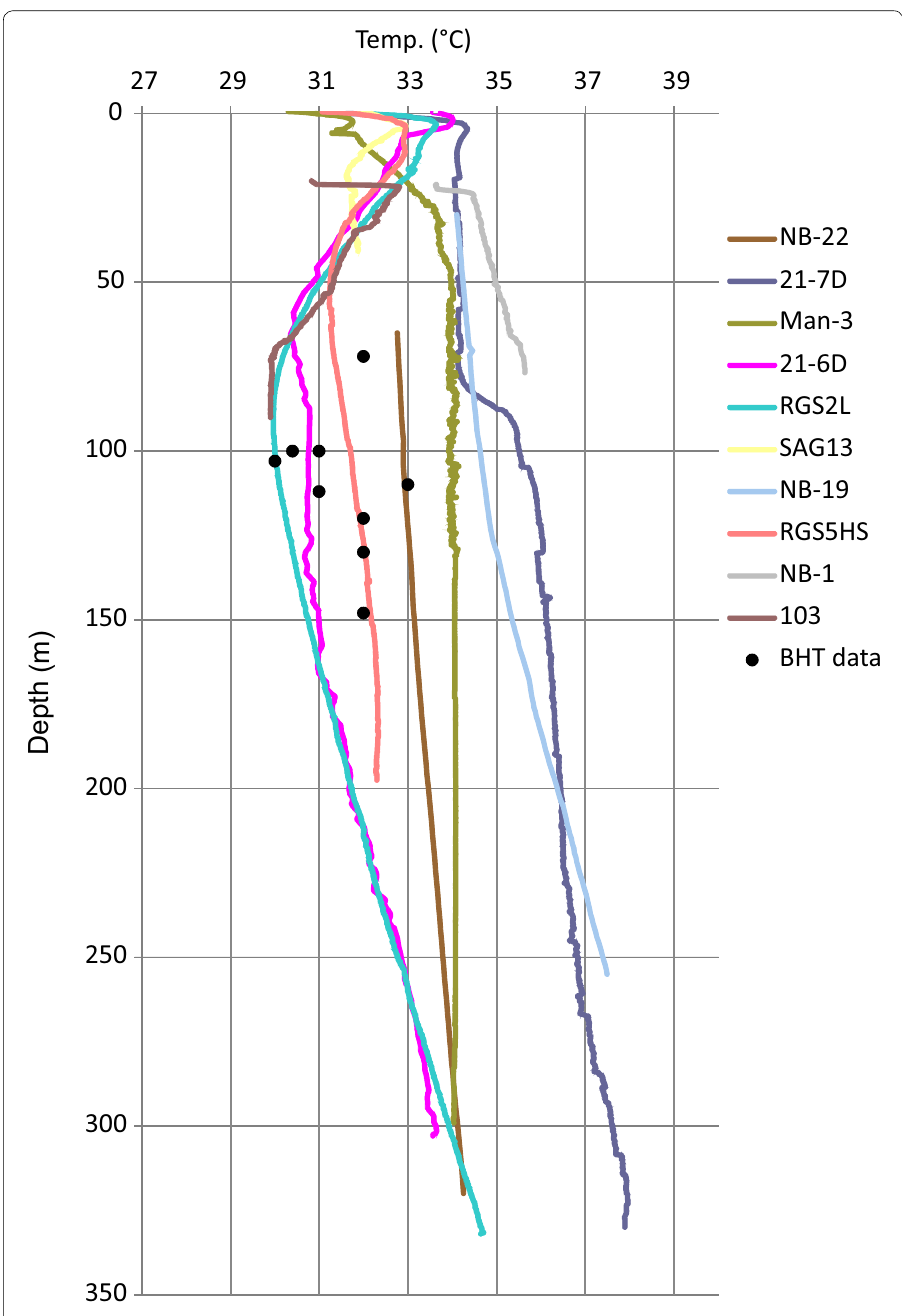
Fig. 4 Continuous T-logs measured with a conventional temperature probe in seven wells during this study. Additionally three continuous T-logs (NB-1; NB-19; NB-22) and bottom-hole temperatures (BHT), provided by the MRMWR, measured in a cluster of nine wells close to the Al Khawd dam (for location see Figs. 1,